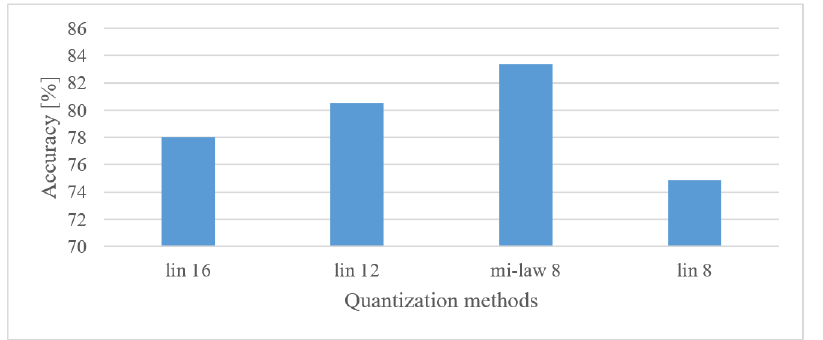
Figure 19. Accuracies for 16, 12, and 8 bit linear, and 8 bit μ -law quantization schemes in the case of 1 s-long spectrograms covering a range of 100 Hz–17.5 kHz.